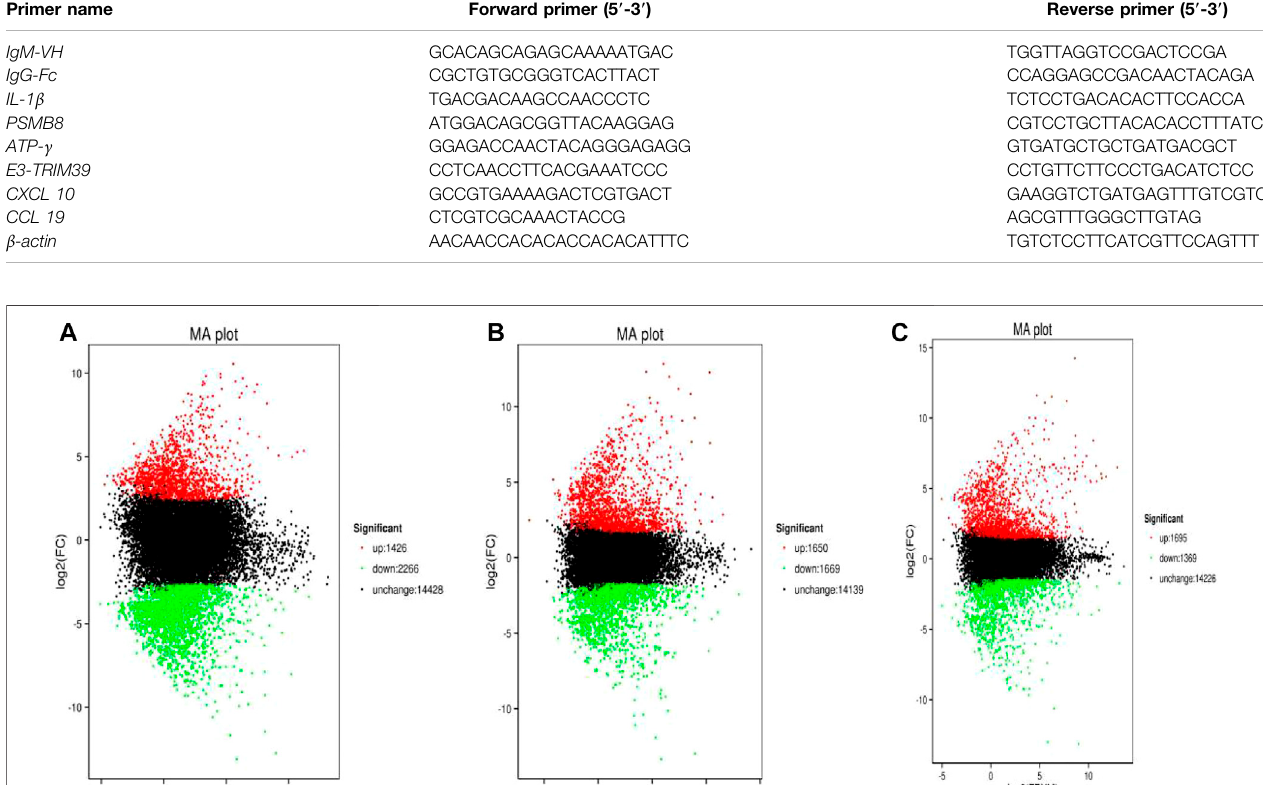
Frontiers in Genetics |